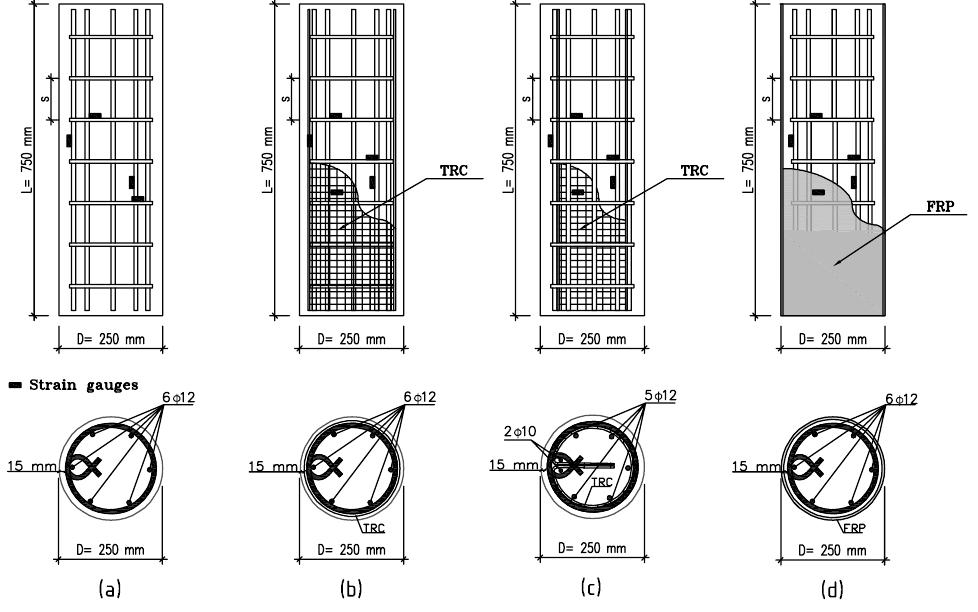
Figure 1. Geometrical and reinforcement properties of all HSC-tested columns. ( a ) TSR-confined specimens, ( b ) specimens with TRC wrapped externally around the reinforcement cage, ( c ) specimens with TRC located around the inner perimeter of the reinforcement cage, ( d ) FRP-TSR confined